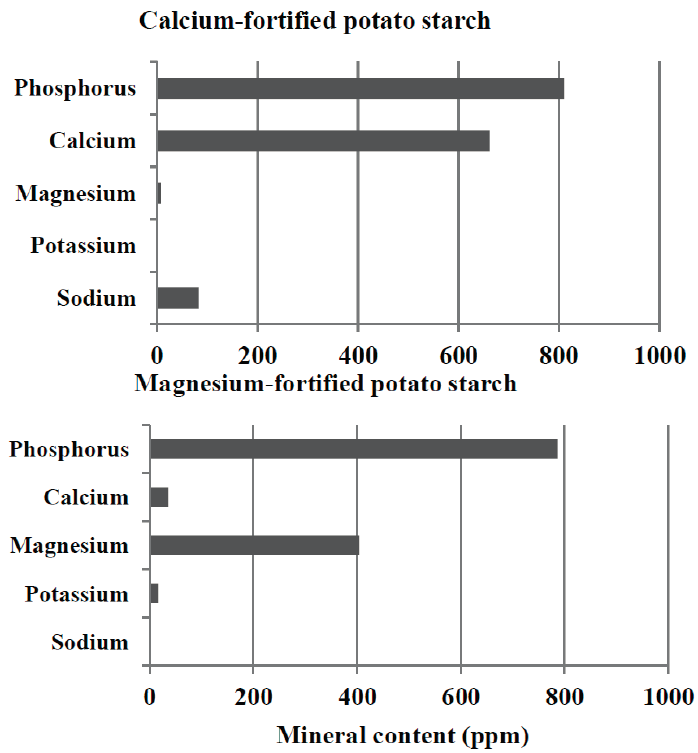
Figure 4. The content of phosphorus, calcium, magnesium, sodium, and potassium of the calcium- and magnesium-fortified potato starches.